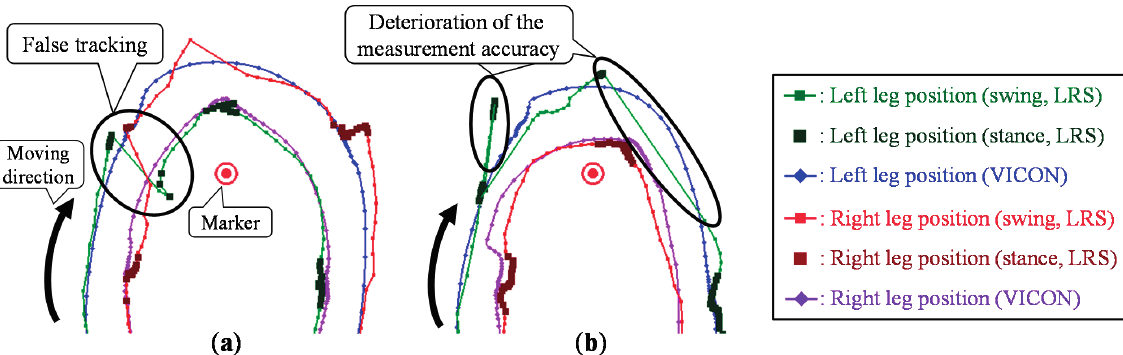
Figure 2. Top view of the leg trajectories and the problems to be solved for the TUG measurement. ( a ) False tracking. ( b ) Deterioration of the measurement accuracy during the occlusion.